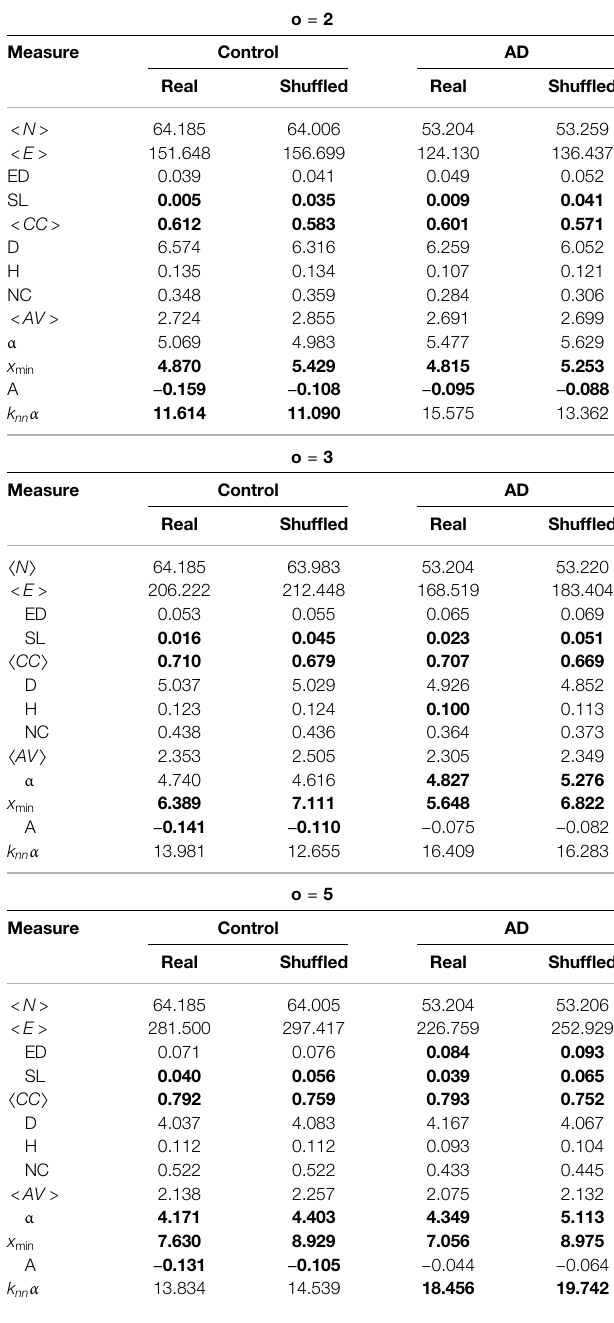
TABLE3| Comparisonofthenetworkmeasuresfortheshuf fl ednetworksandthe real ones. Signi fi cant differences are marked with bold